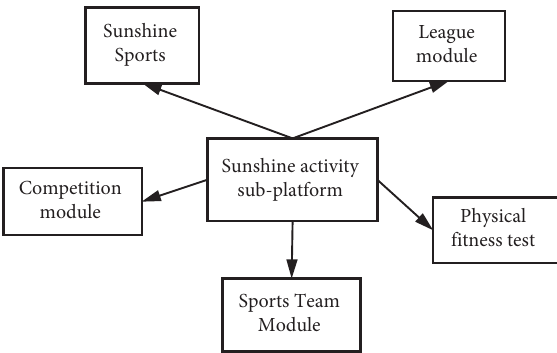
Figure 6: Framework of sunshine sports